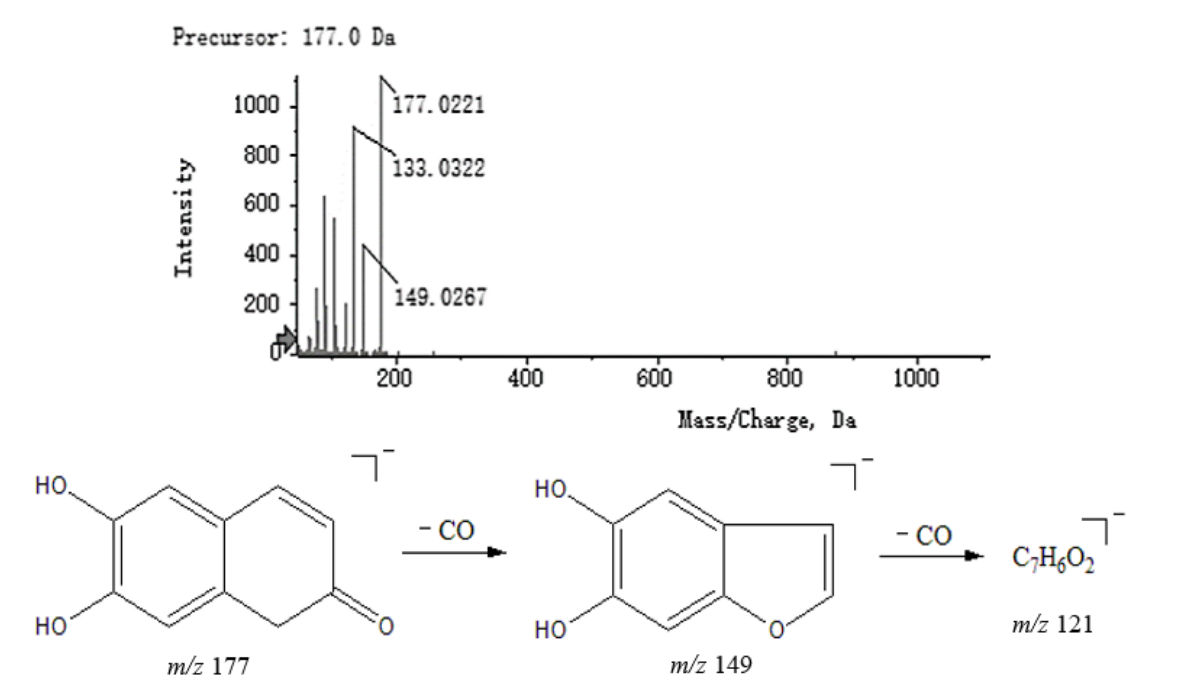
Figure 8. MS 2 spectrum of 6,7-dihydroxycoumarin and speculated fragmentation pathways.